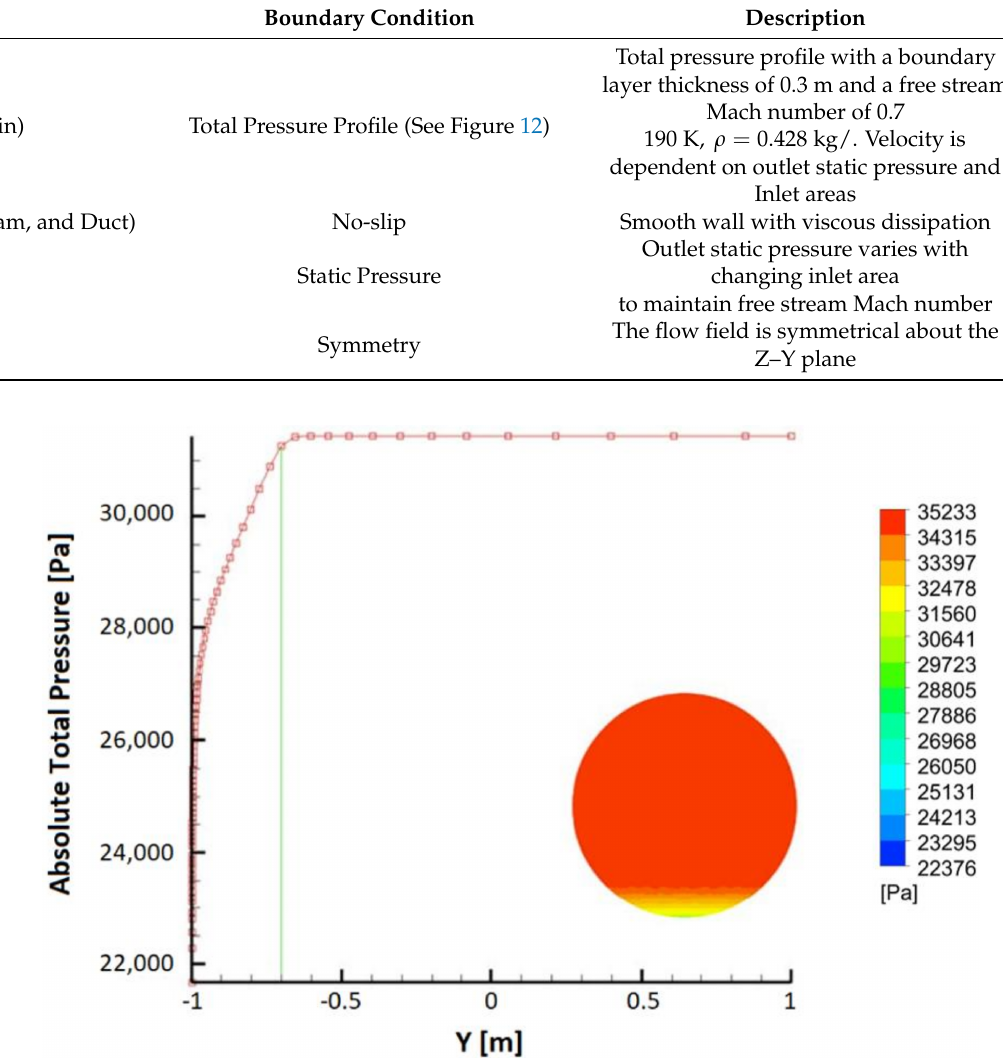
Table 3. Boundary conditions used for the simulations.